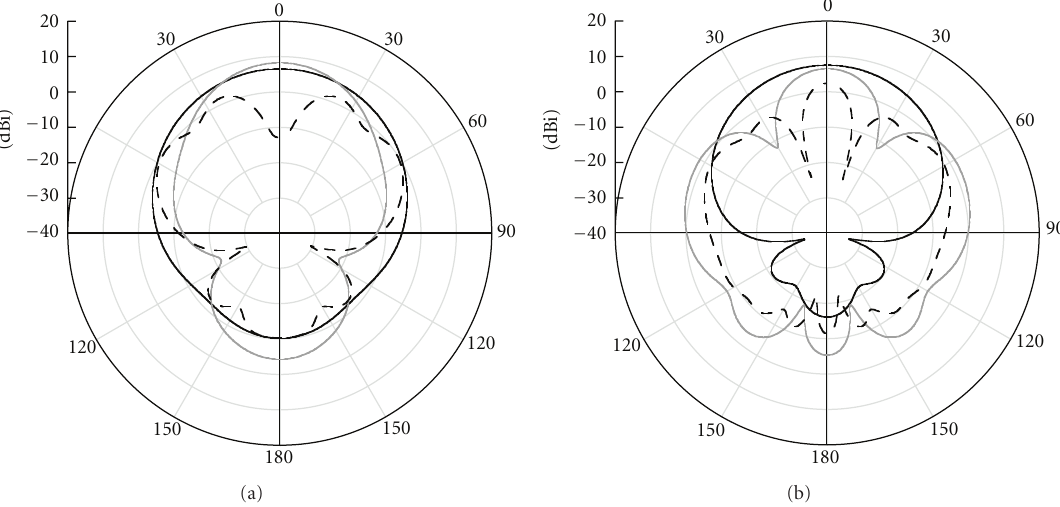
Figure 7: Antenna in Figure 2. Gain in polar form on the principal elevation plane φ = 90 ◦ of the single element at di ff erent frequencies in the operational bandwidth 5–25 GHz: 5GHz ( solid black line ), 10 GHz ( gray line ), 20GHz ( dashed black line ). (a) Ports 1 and 2 feed the upper element, exciting a field along the θ direction. (b) Ports 3 and 4 feed the lower element, exciting a field along the ϕ